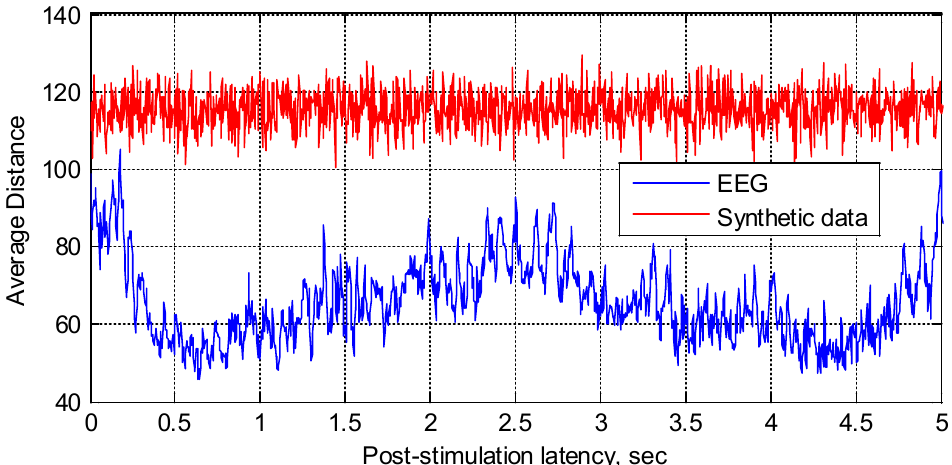
Figure 4. Distance averaged over 10 EEG epochs (one arbitrarily selected participant, single-trial, and “5-s” stimuli) and over 10 sets of synthetic data.